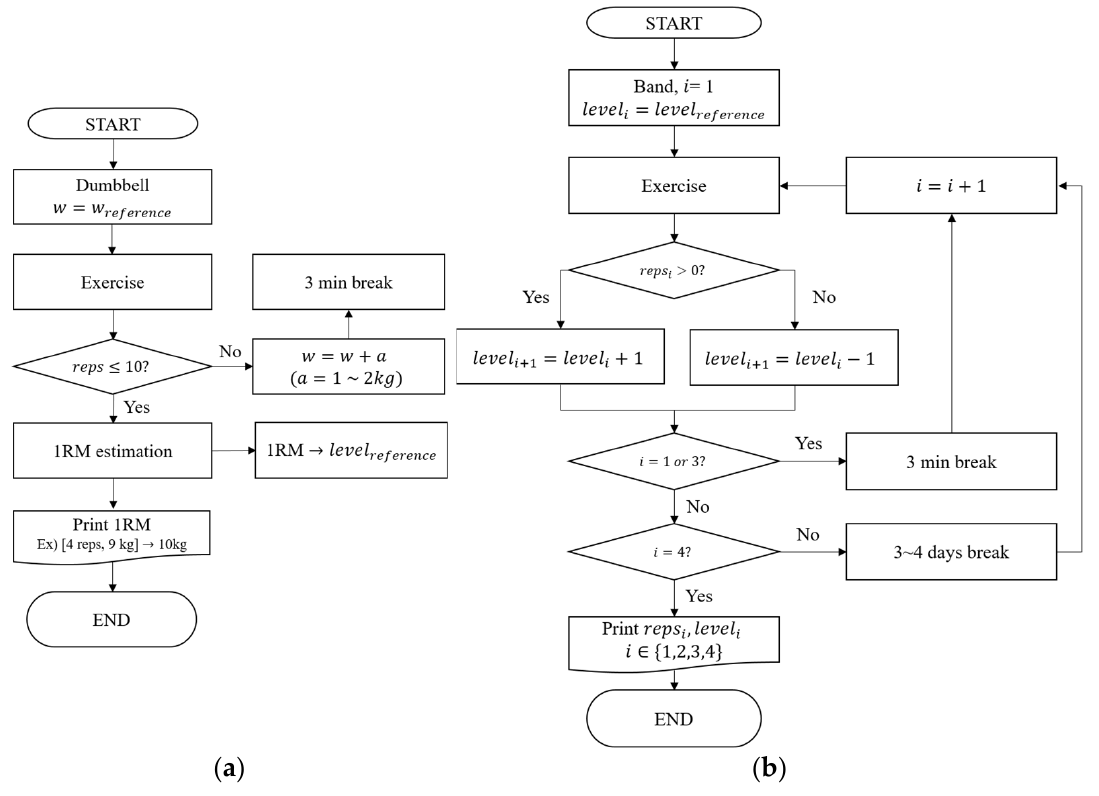
Figure 2. Flowchart of ( a ) dumbbell 1 − RM estimation and ( b ) band force.